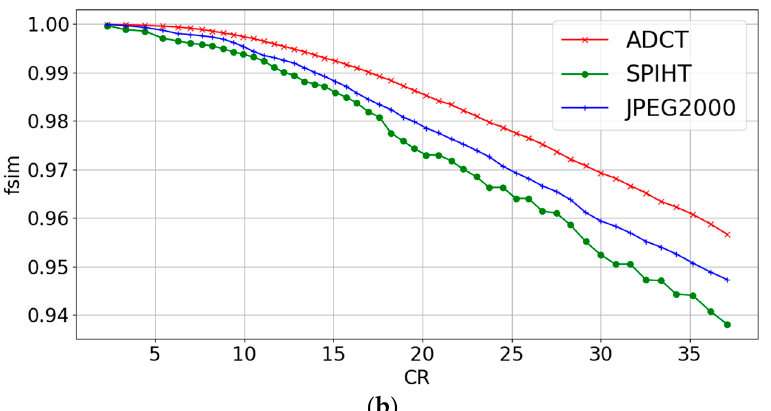
Figure 4. Dependences of A Feature Similarity Index (FSIM) on compression ratio (CR) for simple structure ( a ) and complex structure ( b ) image fragments.